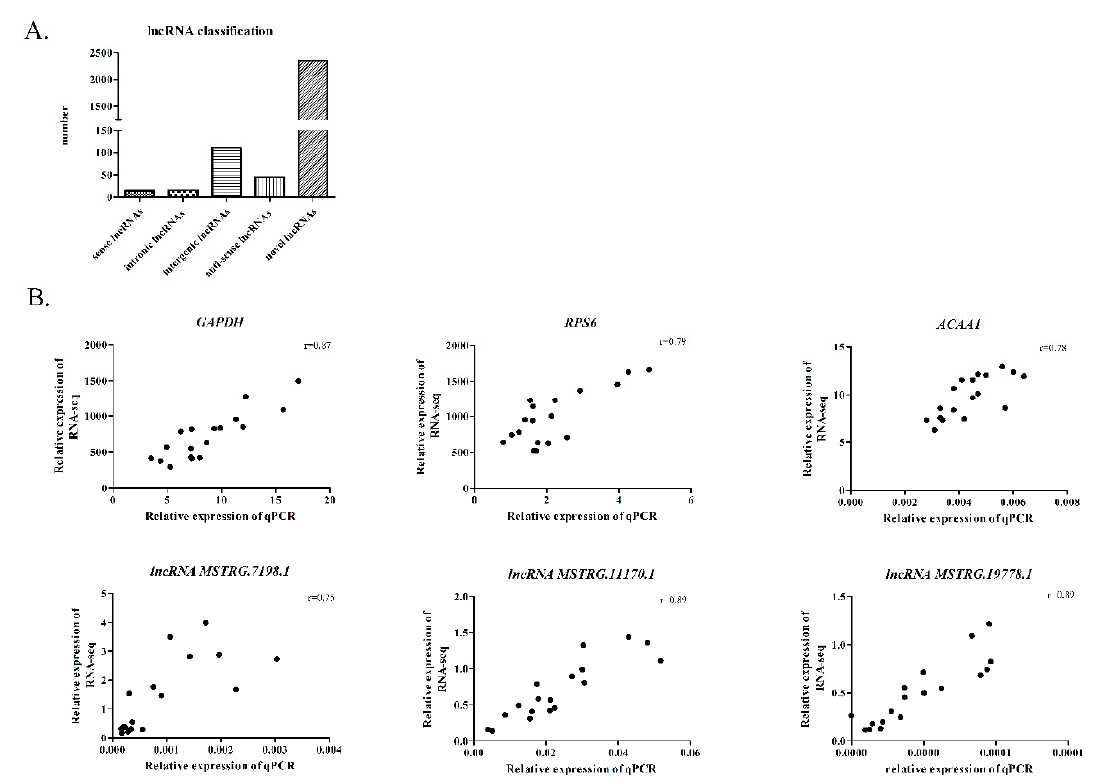
Figure 1. Profile of the RNA sequencing. ( A ) Classification of the long non-coding RNAs (lncRNAs) in our study. ( B ) Validation of three differentially expressed genes (DEGs) and three differentially expressed lncRNAs (DElncRNAs) by qPCR.